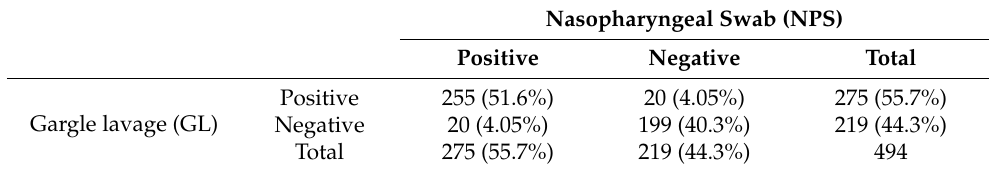
Table 2. Results of rRT-PCR SARS-CoV-2 detection in paired nasopharyngeal swab and gargle lavage samples.